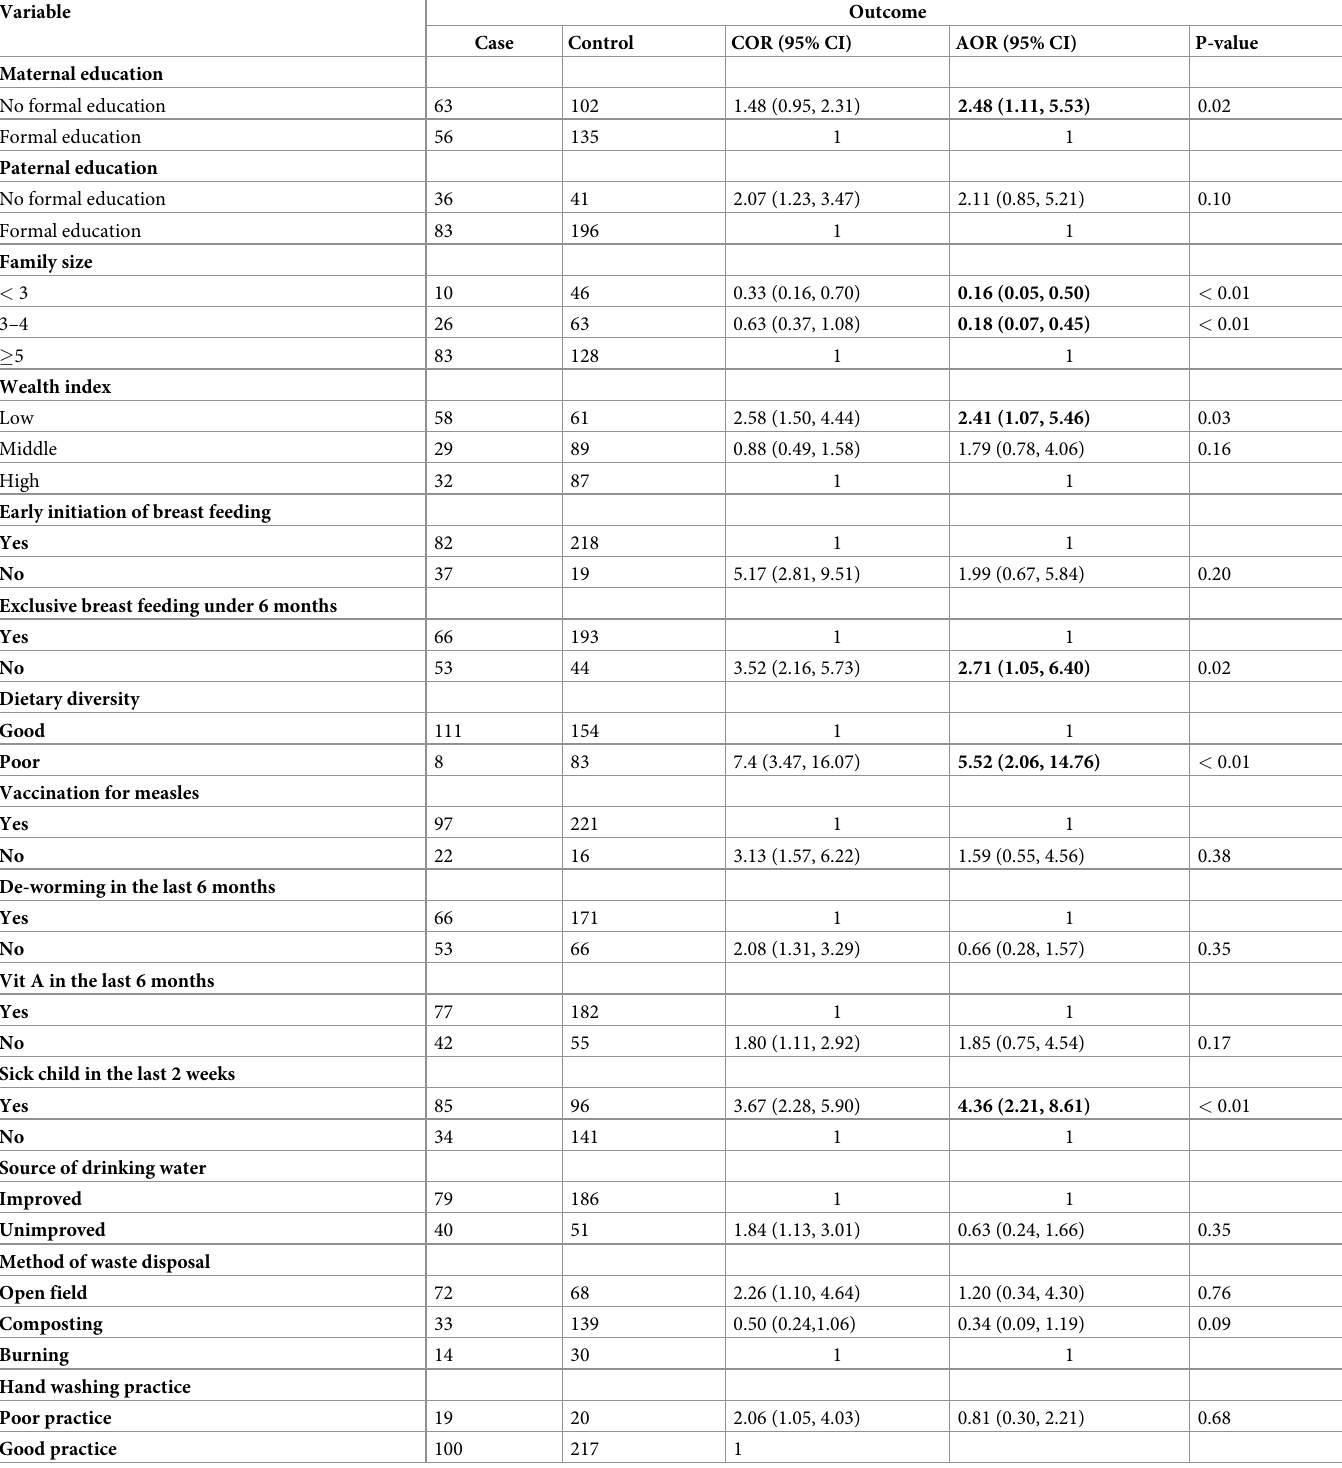
Table 3. Determinants of wasting among children aged 6–59 months in Wonago Woreda, South Ethiopia November